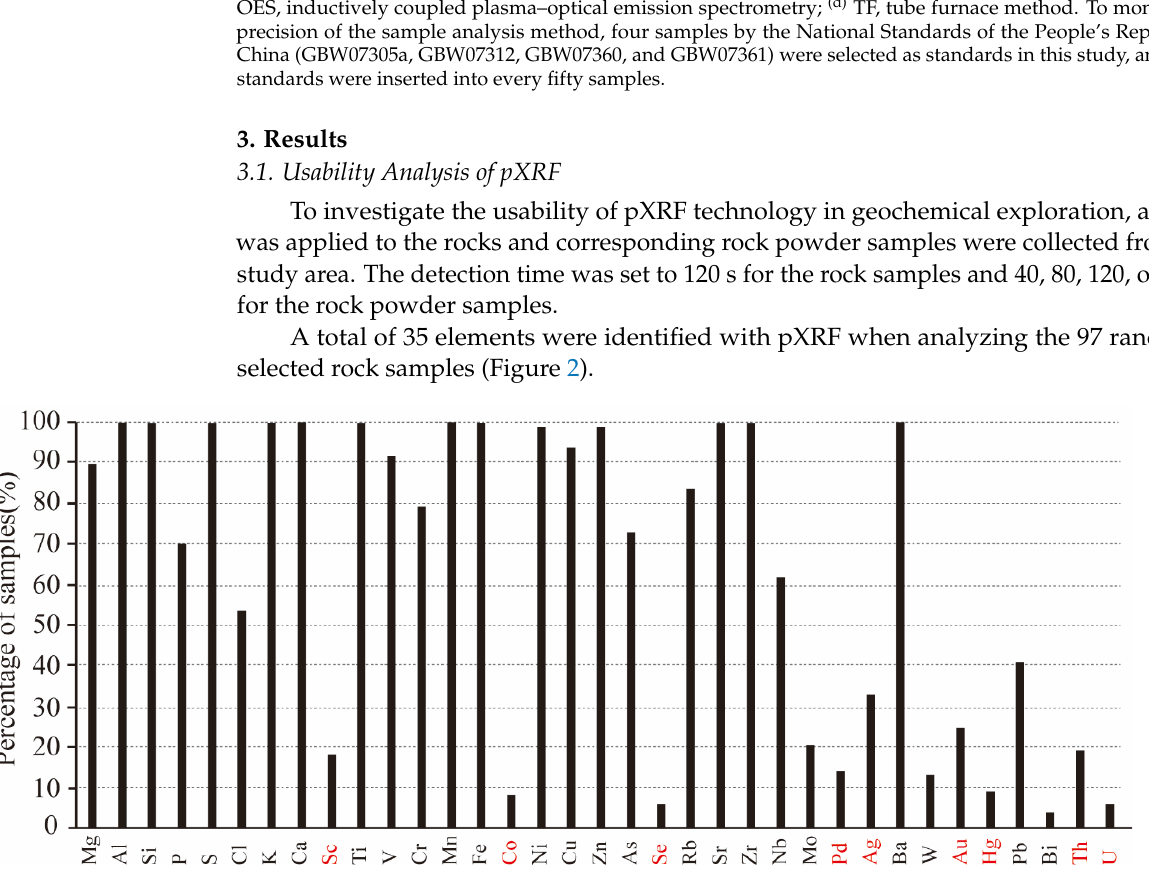
Table 1. List of analytical equipment used to measure the concentrations of the 14 elements.